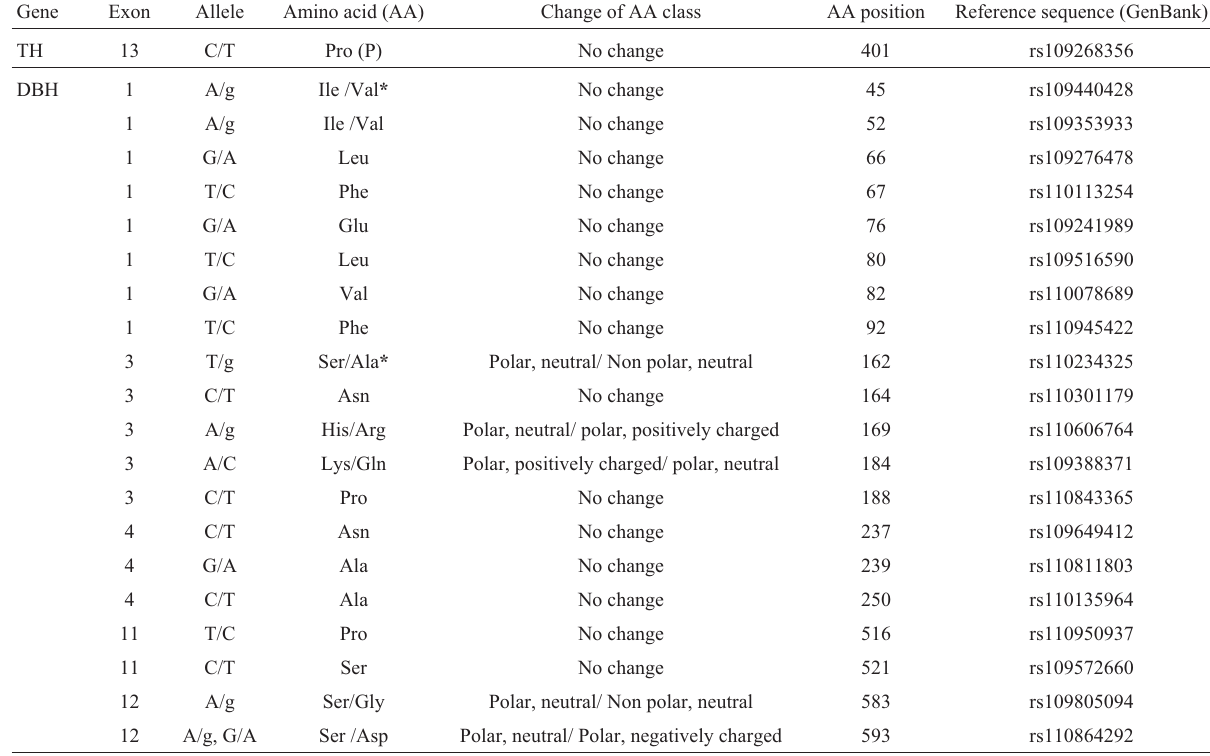
Table 2 - Novel SNPs located in coding regions of bovine TH and DBH